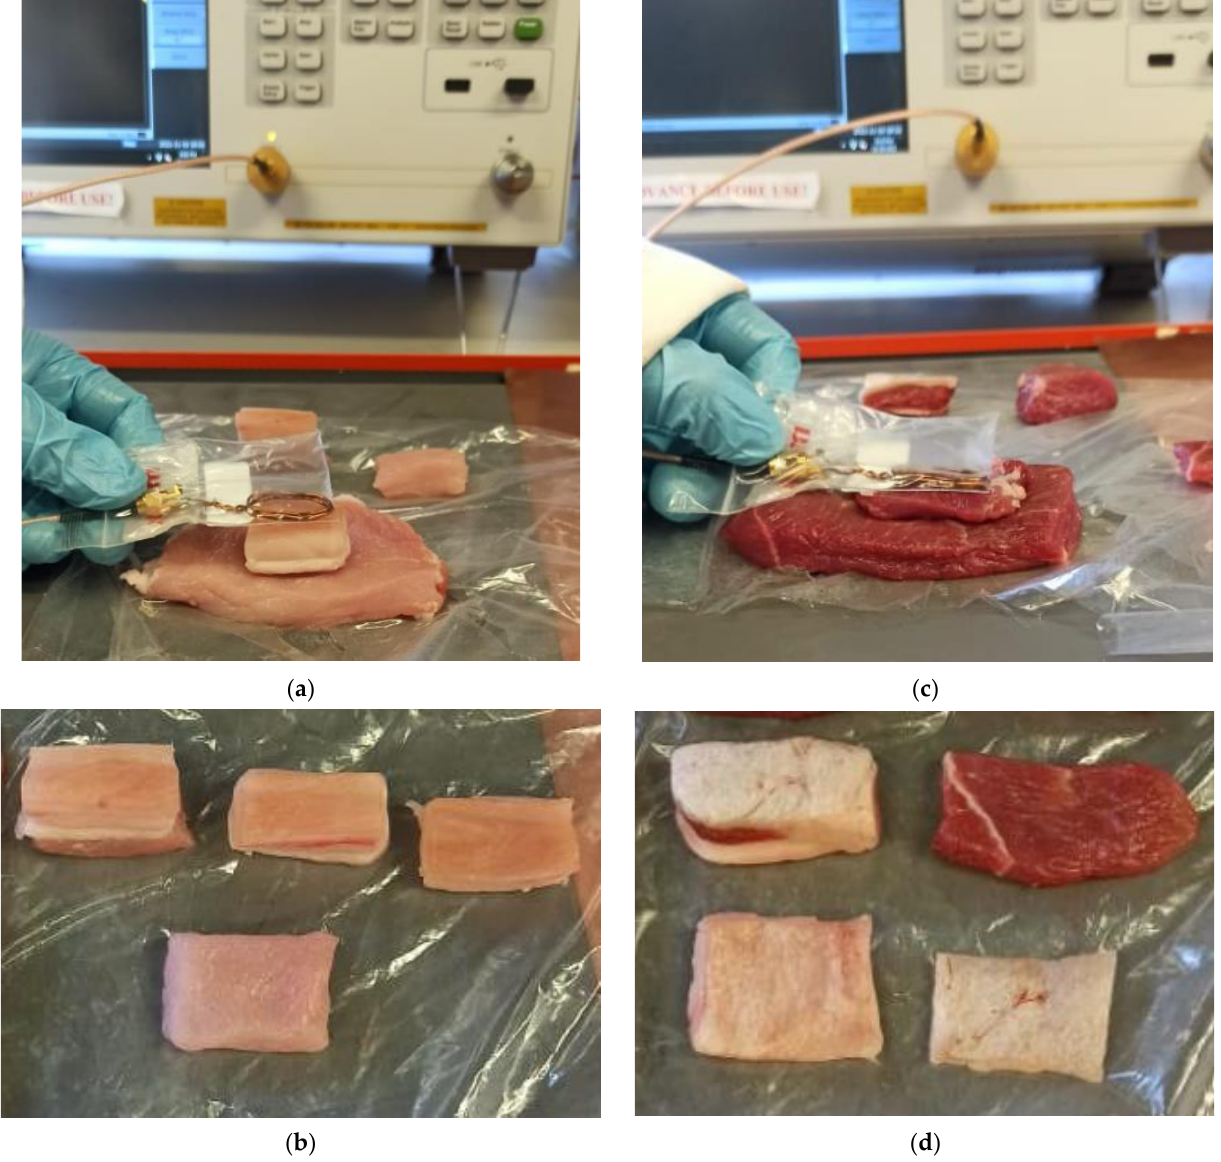
Figure 6. Ex vivo experiment setup for wireless linkage distance investigation. ( a ) Sensor under the porcine skin and fat layers with readout coil outside. For image purposes reader coil is shown in plastic envelope only. ( b ) Layers of different types of porcine tissue. ( c ) Sensor under the ovine muscle layer with readout coil outside. ( d ) Layers of different types of ovine tissue.